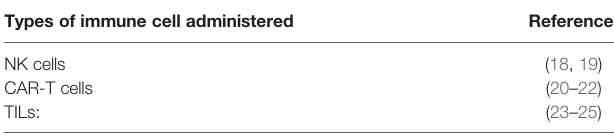
TABLE 1 | Reviews indicating clinical results with different types of immune cells administered in immunotherapy studies in cancer patients. Types of immune cell